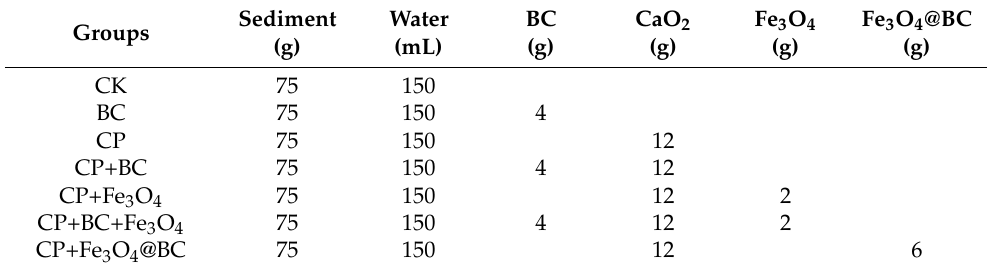
Table 1. Details of the batch